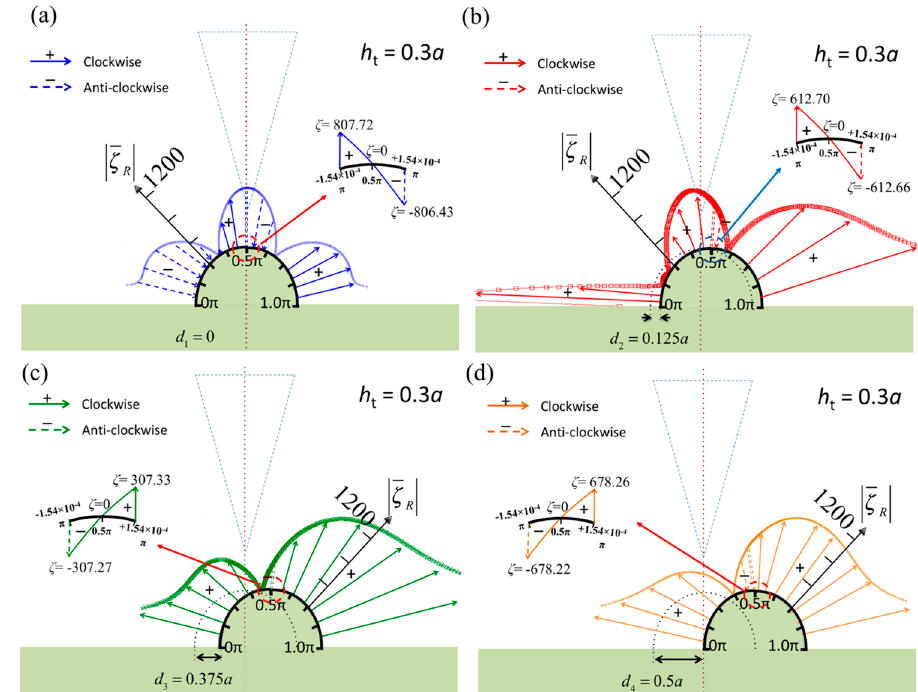
Figure 4. Normalized vorticities in real part over the surface of the semicircular specimen when the diameter of the semicircle d = a , h t = 0.3 a , and the tip is shifted to the left relative to the specimen center line. The shift magnitudes are ( a ) d 1 = 0, ( b ) d 2 = 0.125 a , ( c ) d 3 = 0.375 a , and ( d ) d 4 = 0.5 a . Insets: the zero-vorticity points in the apical specimen.